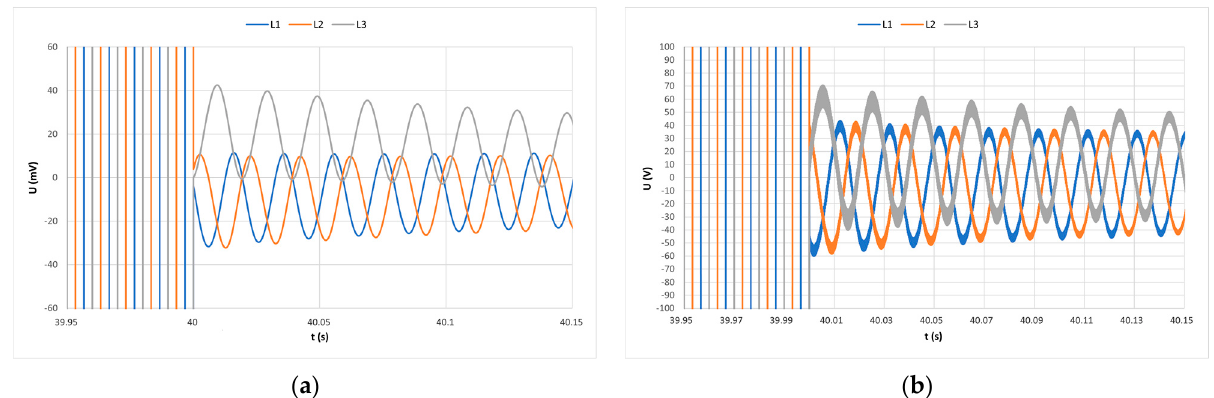
Figure 27. Simulated values of hydropower plant model voltages during a 3-Ph ground fault condition at: ( a ) the source; ( b ) the end of transmission line.